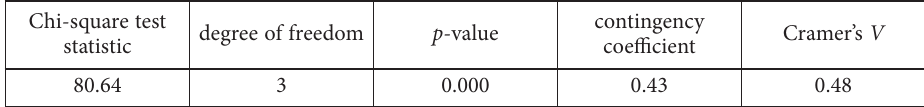
Table 7. Contingency table – observed frequencies for various combinations of essence of controlling and level of ROS Essence of controlling Negative value Up to 2.5% From 2.6% to 5% More than 5% 25 It is not fully used Used in a wider range Total